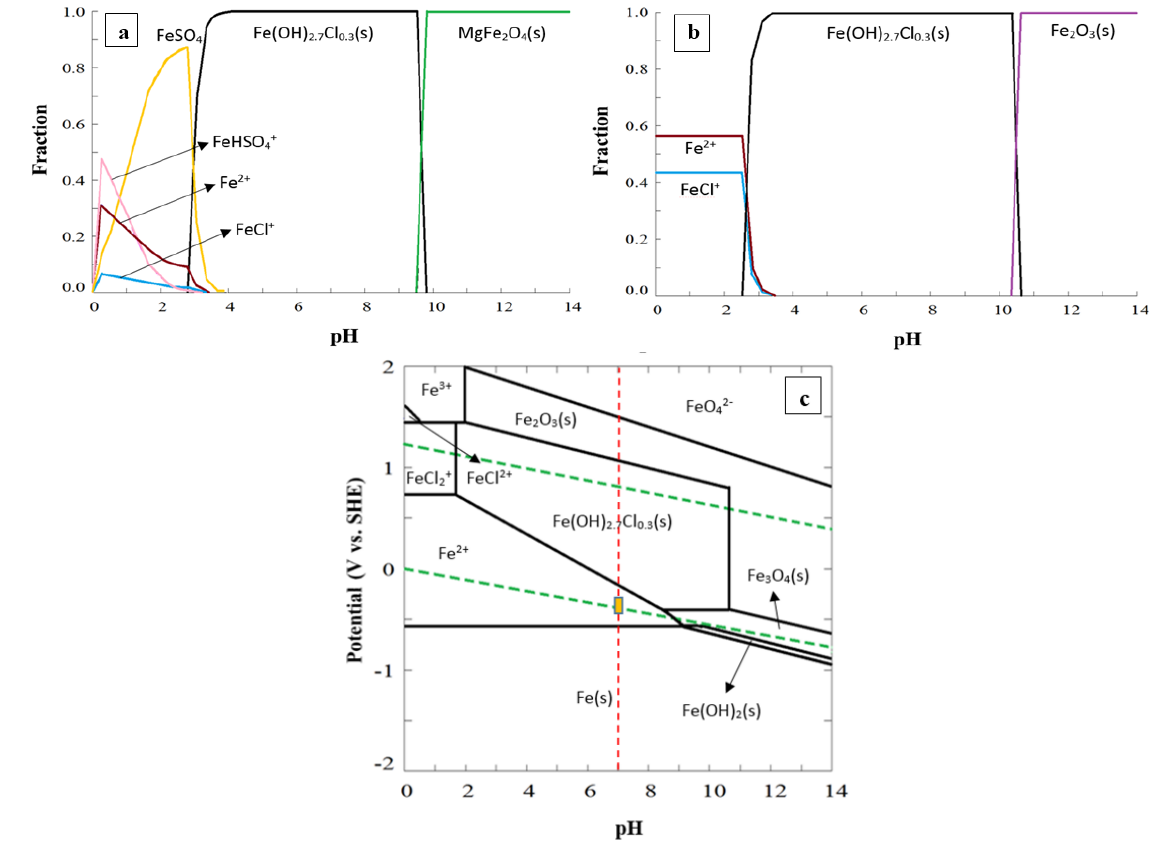
Figure 4. Thermodynamic calculations showing ( a ) multicomponent fraction-pH diagrams for dissolved species (anions and cations) in drinking water including iron (as the main alloying element of the substrate material) with the same concentrations (in molar) as reported in Table 1; ( b ) simplified multicomponent fraction-pH diagram containing only chloride ions at 0.6 M (equal to Cl − concentration in 3.5 wt. % NaCl solution) concentration; and ( c ) multi-component Pourbaix diagram of Fe-Cl-H 2 O system obtained at 25 °C and Cl − concentration of 0.6 M. Note that iron concentration was fixed at 10 −6 M in all thermodynamic calculations.